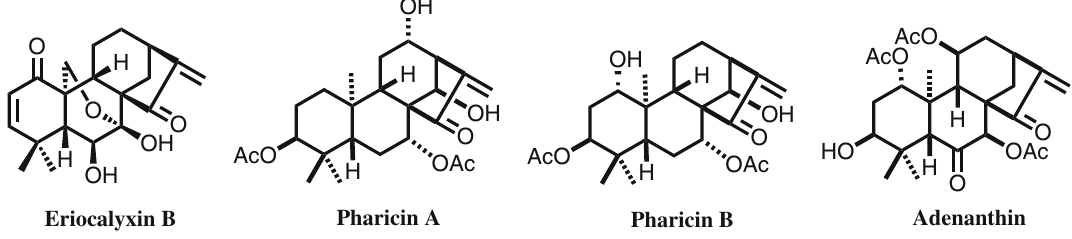
Fig. 6 Representative lead compounds from Isodon